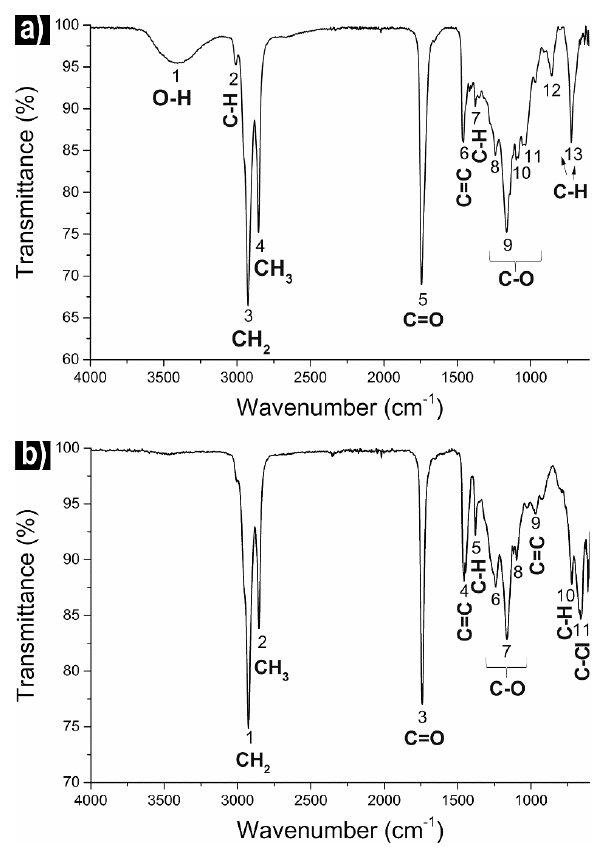
Figure 2. FTIR spectra of Castor ( a ) and Reference ( b ) oil.